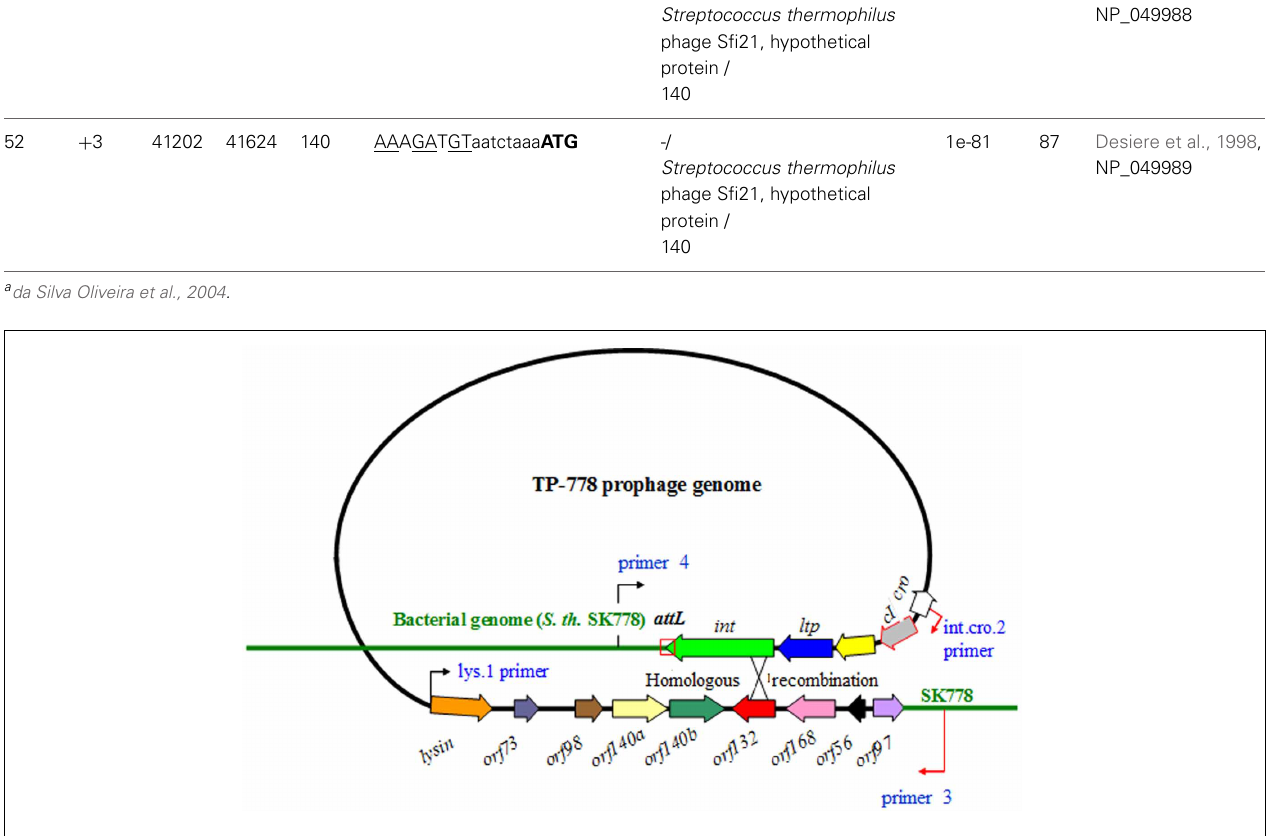
FIGURE 6 | Mechanism of excision of TP-778 prophage from its host’s genome to yield phage TP-778L. Prophage and host DNA are shown by black and green line, respectively. Genes are indicated